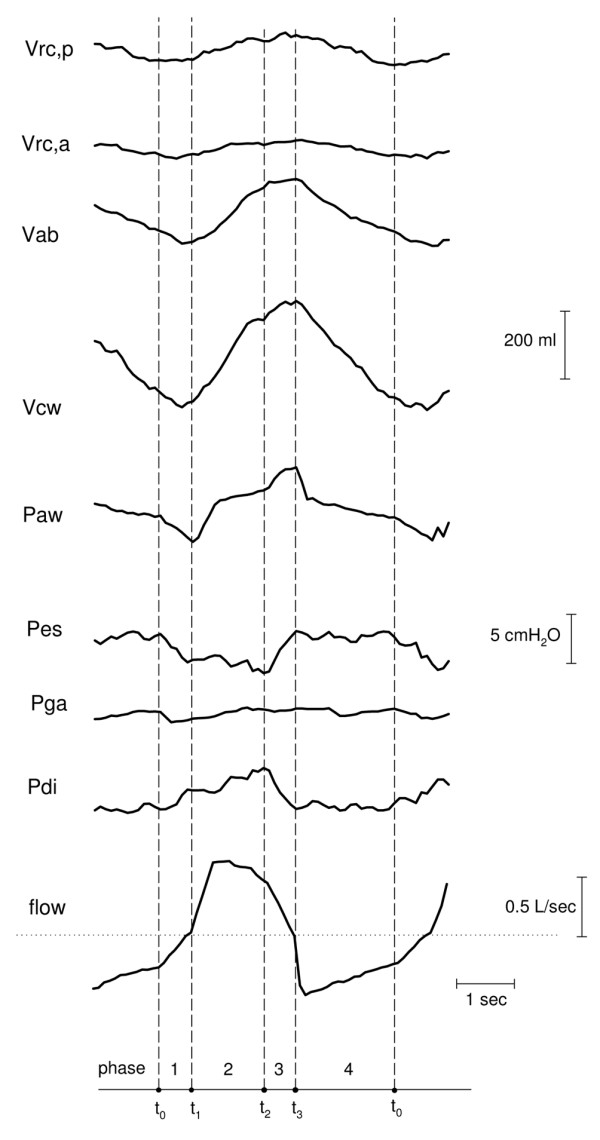
Experimental tracings obtained during a breath from patient receiving PSV (pressure support 5 cmH2O). Time t0 is defined as where Pes starts to decrease; t1 is the onset of inspiratory flow; t2 is where Pes starts to increase; and t3 is the end of inspiration. Vab, abdominal volume; Vcw, chest wall volume; Vrc, a, volume of the abdominal rib cage; Vrc, p, volume of the pulmonary rib cage; Paw, airway pressure; Pdi, transdiaphragmatic pressure; Pes, oesophageal pressure; Pga, gastric pressure.